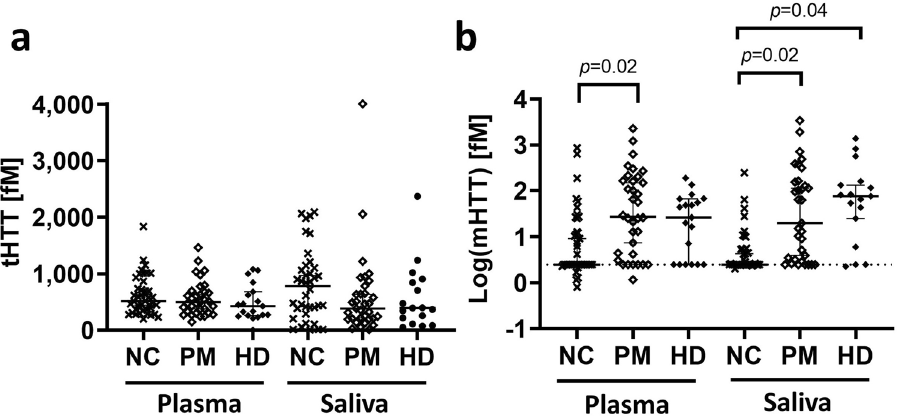
Figure 2. Total HTT ( a ) and mutant HTT ( b ) levels in saliva and plasma of normal controls (NC), premanifest HD individuals (PM) and manifest HD patients (HD). Plasma and salivary tHTT did not differ by